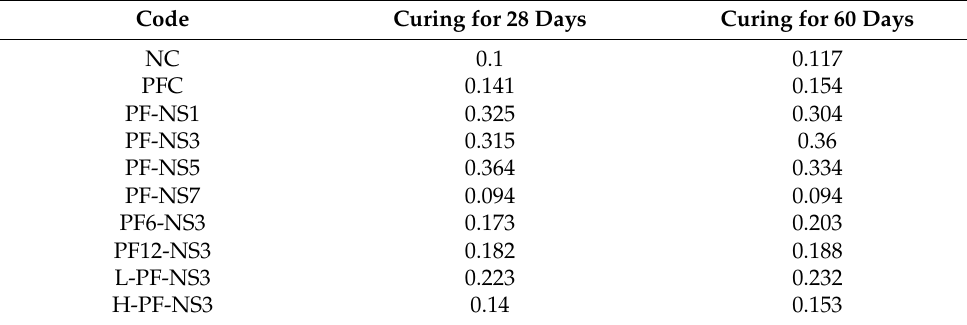
Table 4. Abrasion resistance strength of selected